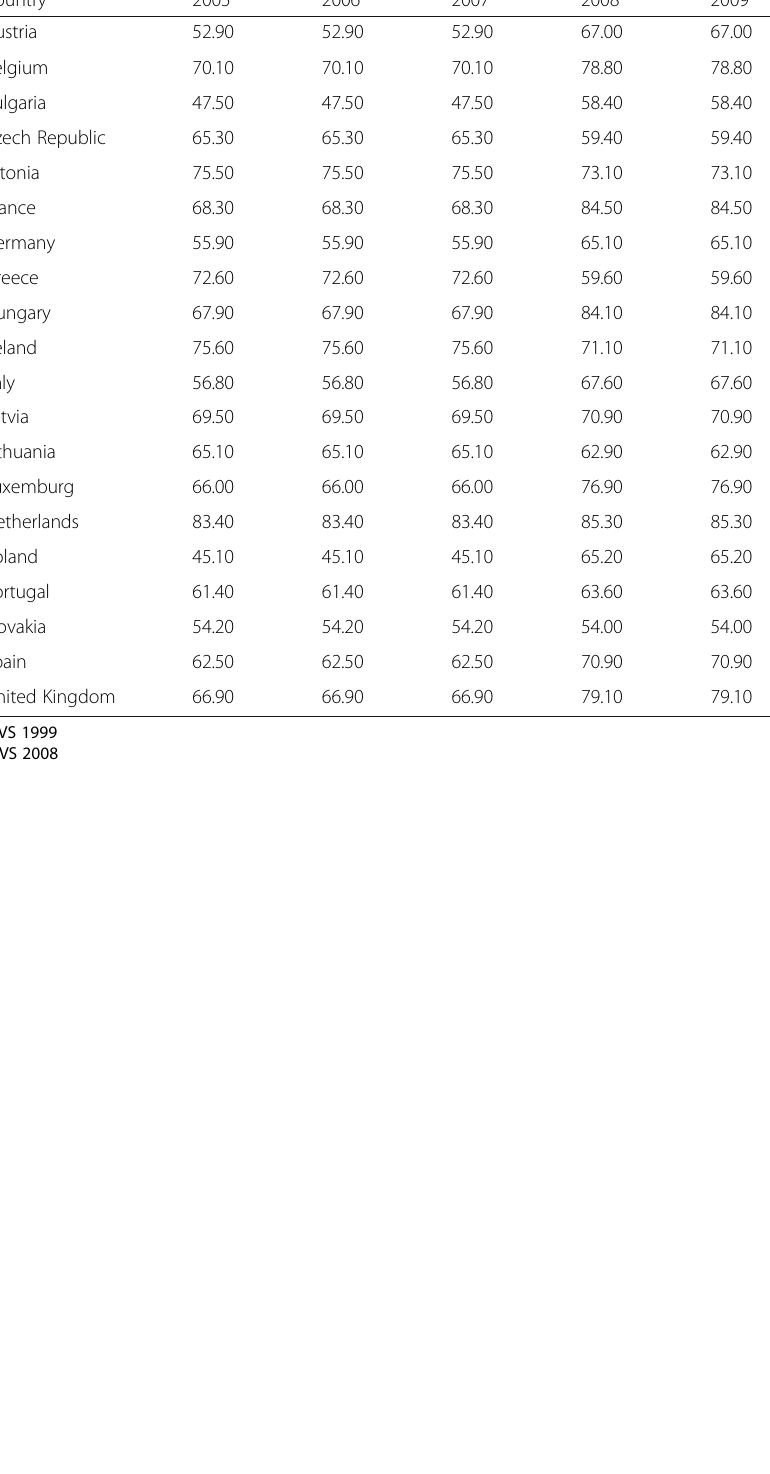
Table 9 Gender egalitarian norms